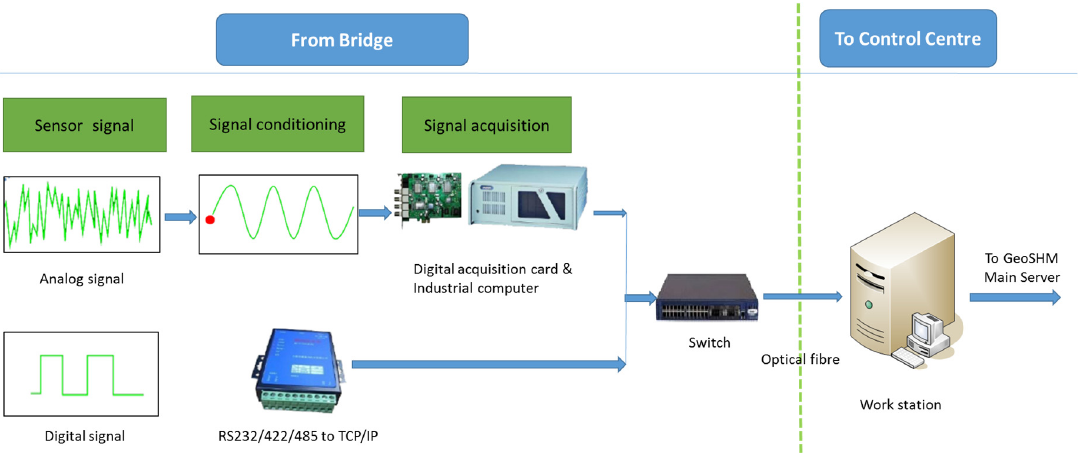
Figure 5. Schematic of GeoSHM data collection and transmission module.